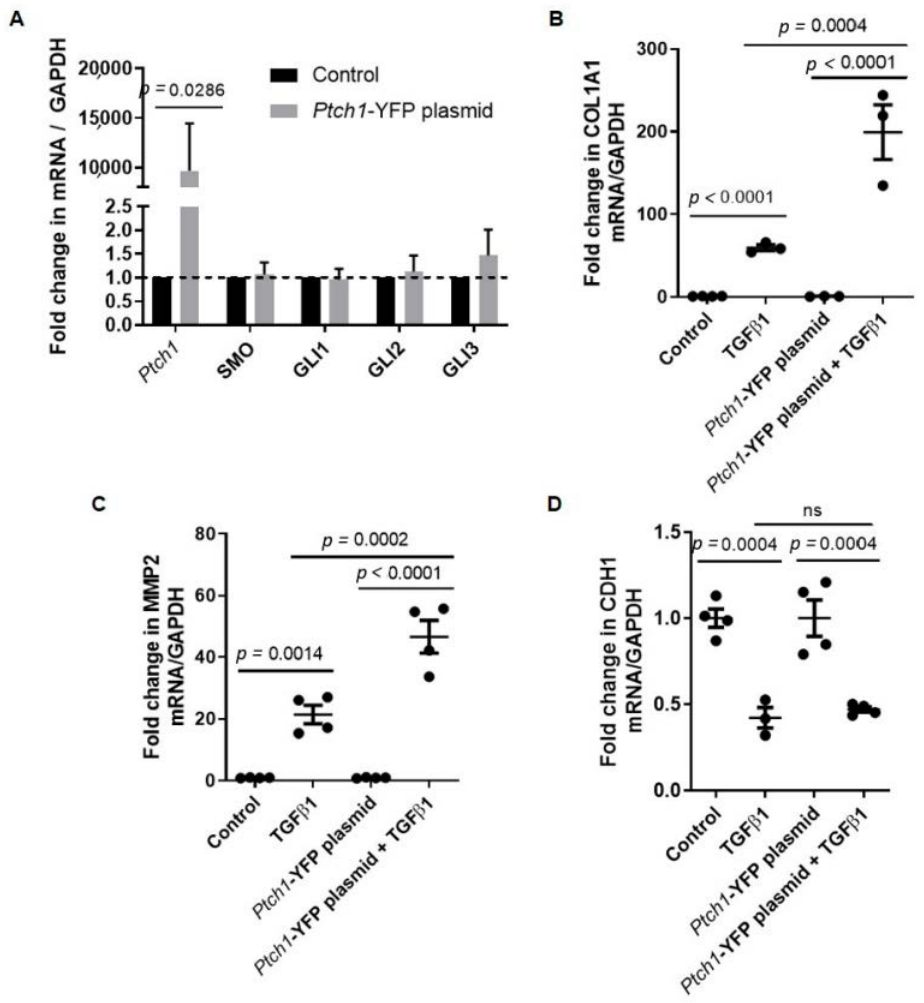
Figure 2. Ptch1 gene over-expression augments TGF β 1-induced increase in COL1A1 and MMP2 gene expression in 1HAE o cells. ( A ) Fold change in PTCH1 , SMO , GLI1 , GLI2 and GLI3 gene expression normalized to GAPDH in 1HAEo cells treated with Ptch1-YFP gene-containing plasmid compared to untreated control were shown. Fold change in ( B ) COL1A1 , ( C ) MMP2 and ( D ) CDH1 gene expression normalized to GAPDH were assessed in cells treated with Ptch1-YFP gene-containing plasmid in the absence or presence of TGF β 1 treatment. ns = not statistically significant. Values were expressed as mean ± SEM (N = 3–4 independent experiments). Parametric t -test or Mann–Whitney test was used in each gene in panel ( A ). One-way analysis of variance with Bonferroni’s multiple comparisons test was used in panels ( B – D